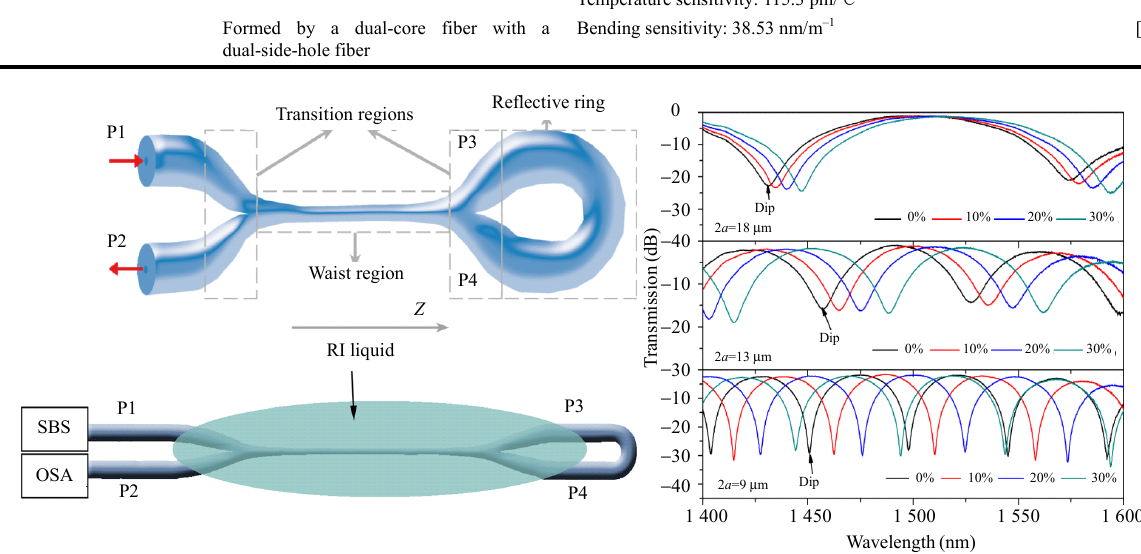
Fig. 26 Schematic diagram of the reflective tapered fiber coupler with Sagnac loop structure and its RI response [186]